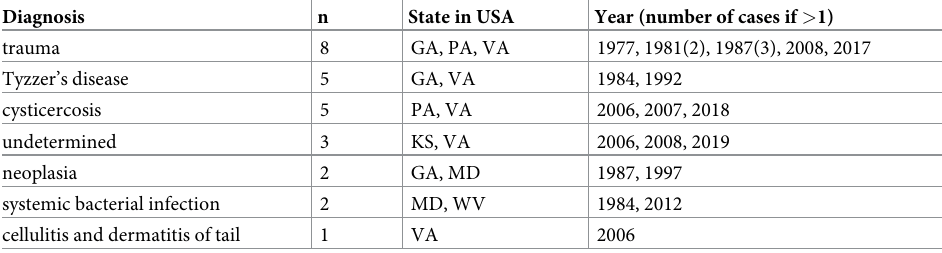
Table 2. Passive surveillance and diagnoses for 26 muskrats ( Ondatra zibethicus ) submitted to the Southeastern Cooperative Wildlife Disease Study, 1977–2019.